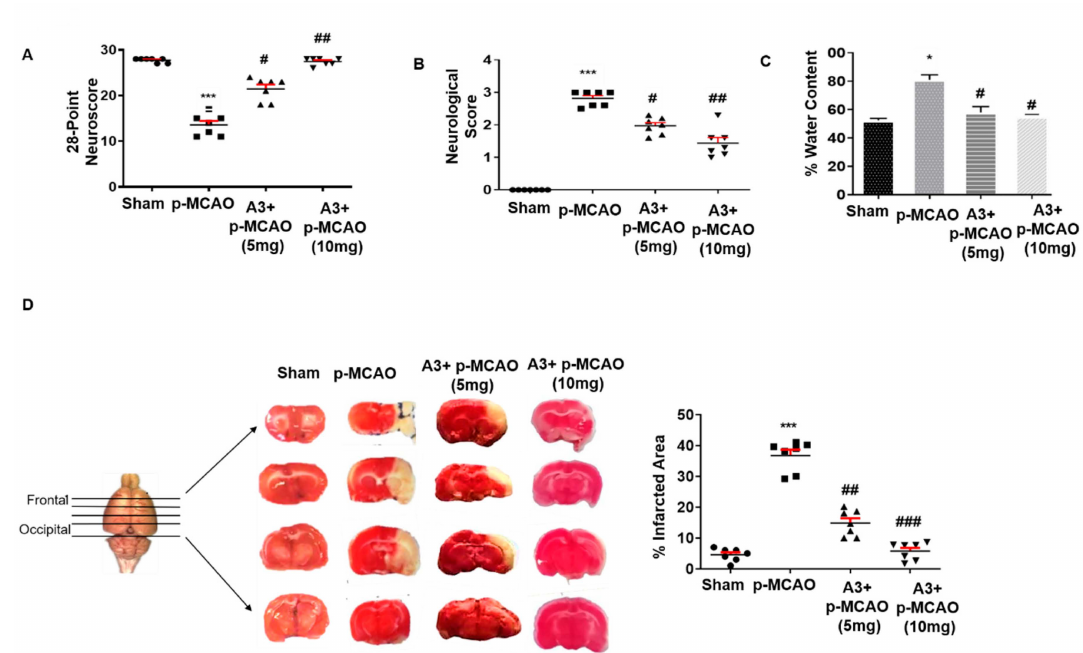
Figure 3. E ff ect of post-treatment dosage regimen of A3 on brain infarction and neuronal cell loss. ( A ) 28 points neuro scoring. *** p < 0.001 vs. sham, while ## p < 0.01 and # p < 0.05 vs. p-MCAO group ( B ) Bederson scale. A3 + p-MCAO rats showed significantly reduced neurological deficits with a higher dose of A3 (## p < 0.01) as compared to p-MCAO rats ( n = 7 / group). *** p < 0.001 vs. sham, while ## p < 0.01 and # p < 0.05 vs. p-MCAO group ( C ) Brain water content. p-MCAO